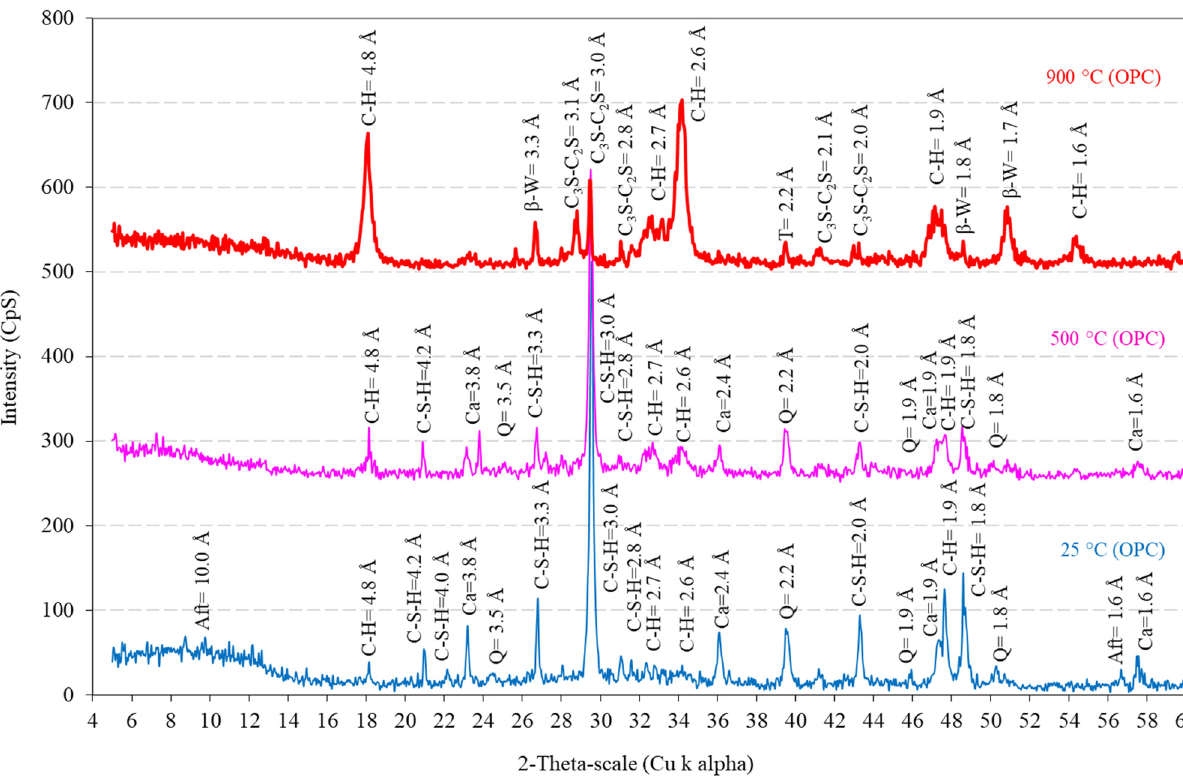
Figure 2: X - ray di ff raction patterns of samples at temperatures of 25, 500, and 900°C. ( AFt: ettringite, C 3 S: alite, C 2 S: belite, C – S – H: calcium silicate hydrate, CH: Portlandite, Q: quartz, Ca: calcite, β - W: β - wollastonite, T: tridymite )